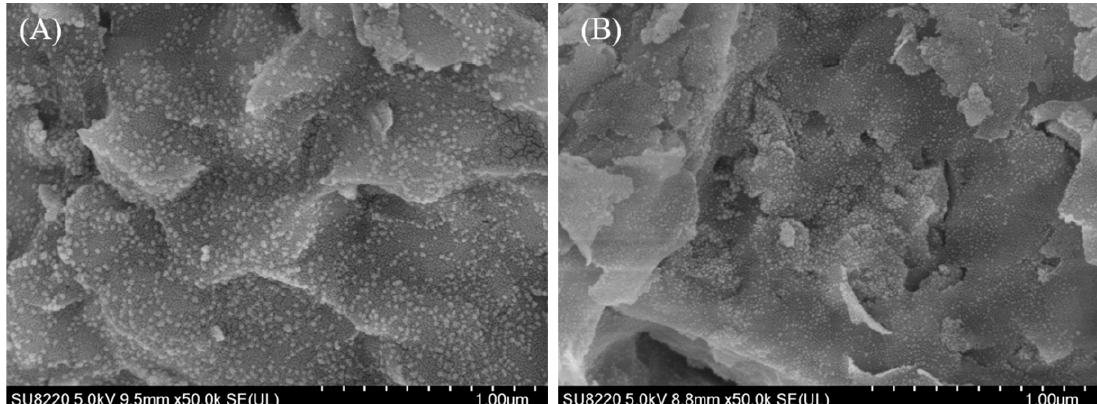
Figure 4. SEM images of the reduced Ni/bentonite-U ( A ) and Ni-2wt%Mn/bentonite-U ( B ) catalysts.